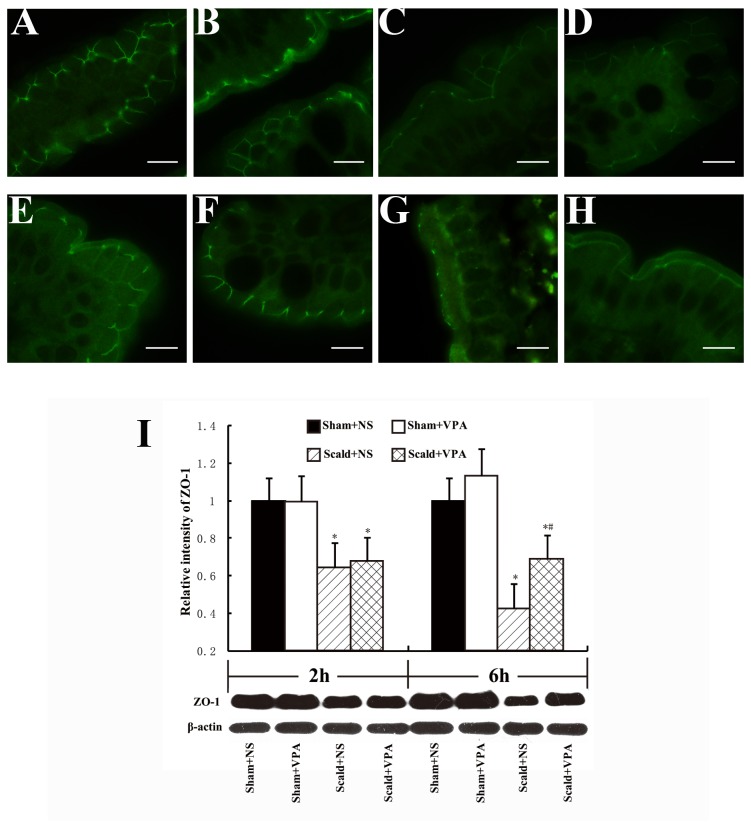
VPA prevents loss of ZO-1.Sections of distal ileum harvested 2 and 6 hours after 55% TBSA burn were labeled for ZO-1 (A-H). A, E and B, F: representative image from sham+NS (A, E) and sham+VPA (B, F) group showing normal intestinal ZO-1 expression; ZO-1 was densely and continuously distributed along the the apical membrane of the epithelial cells; C and G: sections from scald+NS group at 2 and 6 hours, respectively; burn insults caused loss of ZO-1 expression at 2 hours post-burn (C), and the burn-induced loss of ZO-1 was more pronounced at 6 hours post-burn , resulting in a disruption in zo-1 continuity (G); D and H: sections from scald+VPA group at 2 and 6 hours, respectively; the zo-1 continuity were improved compared to control animals at 6 hours. White bar = 10 μm. I: Western Blot analysis of intestinal ZO-1. Burn insults resulted in a significant reduction in intestinal ZO-1 levels at 2 and 6 hours, and VPA treatment significantly increased the intestinal ZO-1 expression at 6 hours post-burn. Protein bands quantified by densitometry were expressed as mean values ± SD (n=5). * P < 0.05, compared with Sham+NS group. # P < 0.05, compared with Scald+NS group.